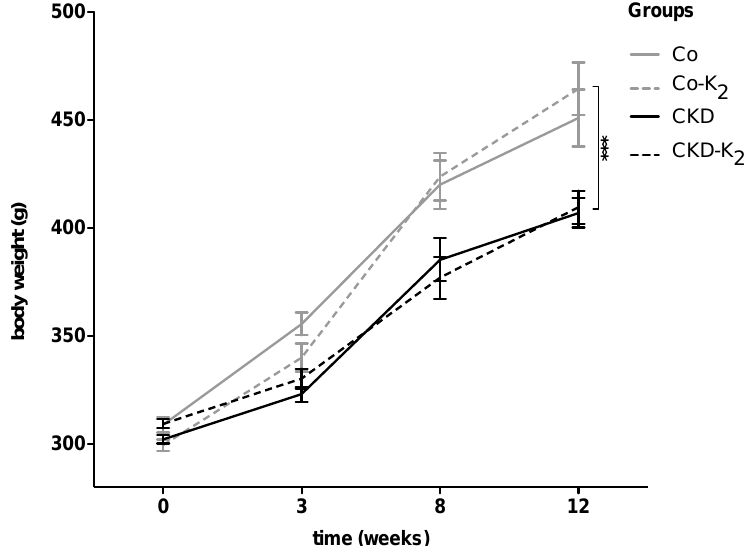
Figure 1. Body weight in grams (g). Body weight of animals was measured repetitively during 12 weeks of study protocol. Experimental animals were not fully grown at start of the experiment; however, all animals gained weight significantly. During the experiment, control animals (Co; Co-K 2 ) gained significantly more weight compared to CKD and CKD-K 2 animals. Co = control group; Co-K 2 = MK-7 supplemented control group; CKD = 5/6 nephrectomized group; CKD-K 2 = MK-7 supplemented 5/6 nephrectomized group; g = grams. Significant differences: *** p < 0.001.